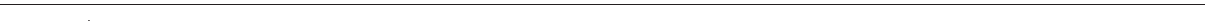
FIGURE 5 | (outlined in dashed lines) and pulp from three different patients (left, volumes of pulp—a–c) are shown. DPI (yellow box, XRF maps) express higher zinc and calcium counts, but pulp (green box) also contains phosphorus (regions of white in green box, and pulp a–c, right). (Middle row, Left to right) The DPI with dentin and its occluded tubule contains particulates (yellow arrows) with higher Mg counts (red star at location 3, red graph to the right). Inter-tubular dentin however, contains lower Mg (blue star at location 2, blue graph to the right) counts but higher than Zn-rich mineralized pulp. (Bottom row) Atomic percentages of elements at locations (1, 2, and 3) are shown in the table. Ca and P contents of location 1 are different from those at locations 2 and 3, and elemental contents of 2 and 3 are similar. Atomic percentage of Mg at location 3 is slightly higher than location 2. (B) Top three rows: Spatial elemental maps from regions 1 (low), 2 (medium) and 3 (high) mineralized extracted pulp contain spherulitic minerals of higher counts of C in less mineralized regions, and aggregates of these spherulitic minerals with higher counts of Zn, Ca, P, and Mg in more mineralized regions of the same pulp. Fourth row: X-ray spectra illustrate energy peaks of elements (Ca, P, Mg, Na, F, C, N, S, O, Zn) from lower (1), medium (2) and higher (3) mineral density regions. Atomic percentages of elements at these locations in maps 1–3 are summarized in table (fifth row). Bottom row (bar charts): Principal component analysis illustrated phases 1, 2 and 3 (P1–P3) in lower, medium and higher mineral density regions of pulp with significant variances in C, P, Ca, S, and Mg. The first phase P1 accounts for more than 70% of the variance in lower, medium, and higher mineral density regions of pulp. In the lower mineral density pulp in map 1, C counts per pixel are the highest in P1 (yellow). With increasing mineral density of pulp, Ca and P counts per pixel are highest in P3 (blue) for map1, and highest in P1 for maps 2 and 3; S counts per pixel are highest in P2 (green) for map1, and P3 for maps 2 and 3. XRF units are in counts; mineral density units are in mg/cc; CPS, counts per second